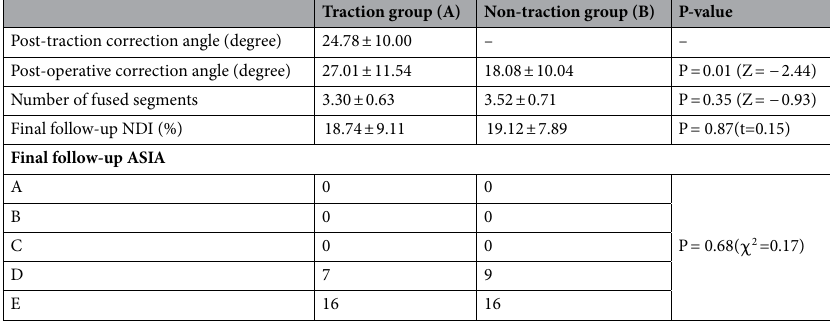
Table 2. Postoperative results between traction group and non-traction group. NDI neck disability index score, ASIA American spinal injury association impairment